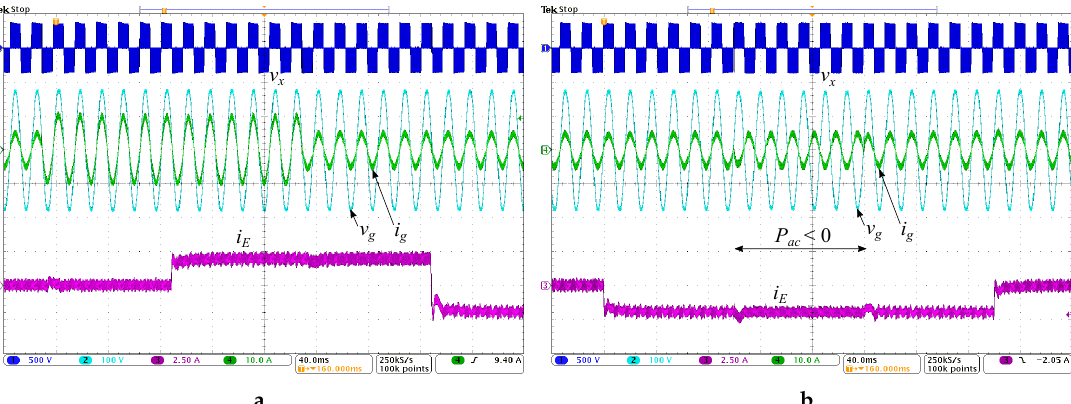
Figure 11. Experimental results showing the step responses of currents i E and i g under different operating modes. ( a ) P ac > 0 and ESS in floating, charging, and discharging modes. ( b ) ESS under floating and charging modes with P ac > 0 and ESS under charging mode with the grid supplying its power ( P ac <